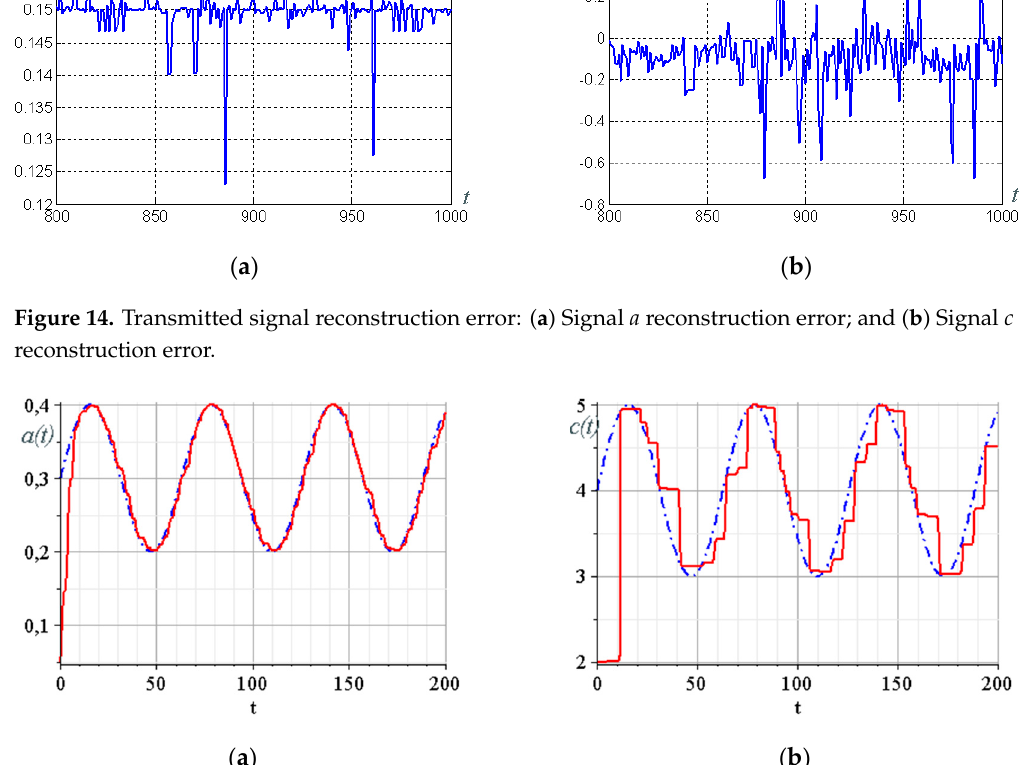
Figure 15. Sinusoidal signal reconstruction with a two channel observer: ( a ) Useful signal a (blue is the initial signal at the transmitter side; red is the reconstructed signal at the receiver side); and ( b ) Useful signal c (blue is the initial signal at the transmitter side; red is the reconstructed signal at the receiver side).